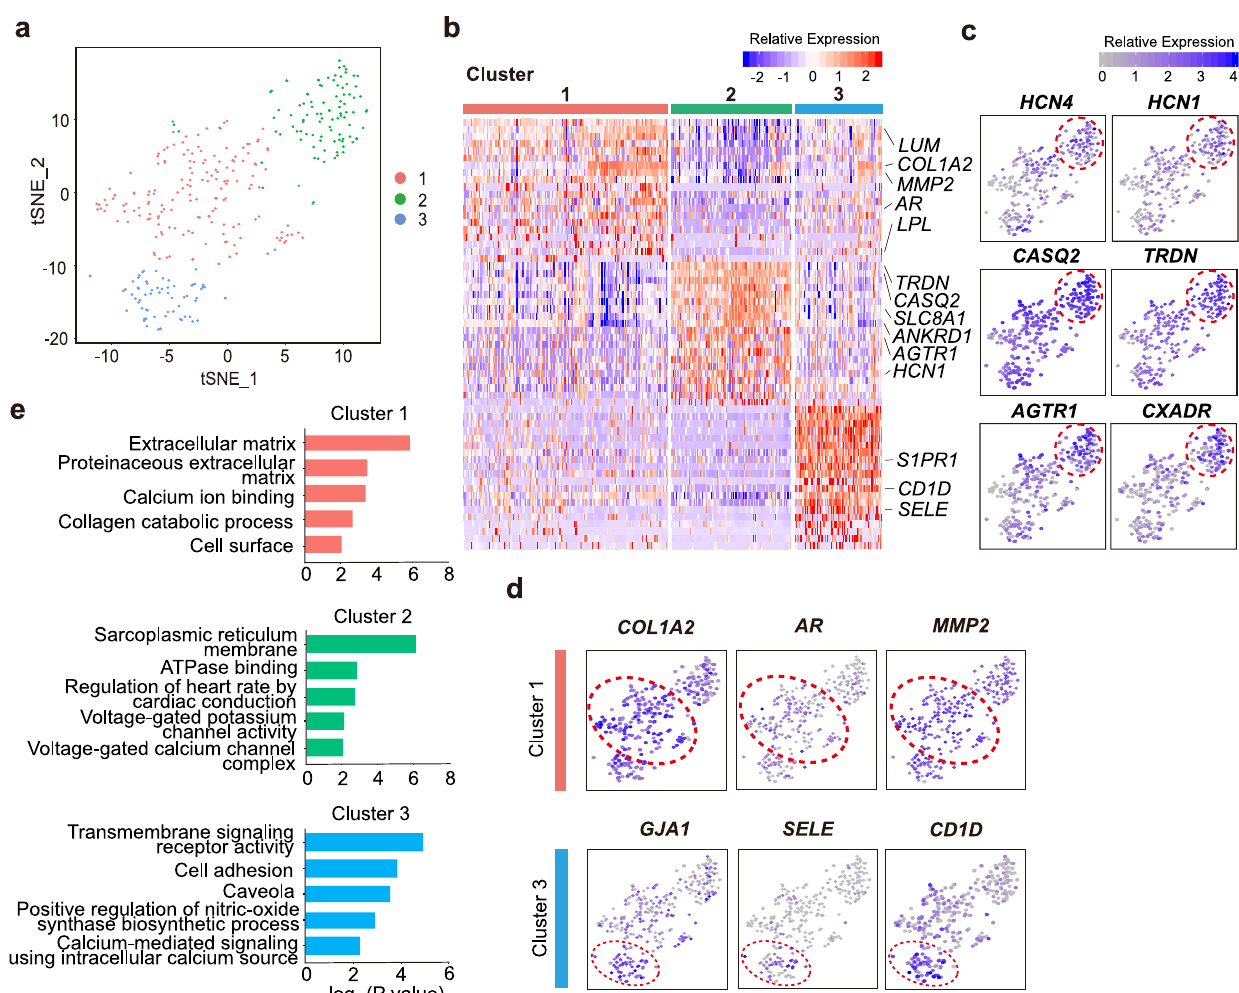
Fig. 6 Cell classi fi cation of rabbit sinoatrial node (SAN) cells. a t-distributed stochastic neighbor embedding (t-SNE) analysis identi fi es three-cell clusters in rabbit SAN ( n = 343 biologically independent cells of six independent animals). b Heat map shows differentially expressed genes (DEGs) of each cluster. c Feature plot of speci fi c DEGs in Cluster 2. d Feature plot of speci fi c DEGs in Cluster 1 and Cluster 3. Location of different clusters was marked with the red circles. e Gene Ontology (GO) analysis of three clusters. Cluster 2 showed it is highly associated with regulation of heart rate, while Cluster 1 was enriched in extracellular matrix and Cluster 3 was related to cell adhesion besides ion channels